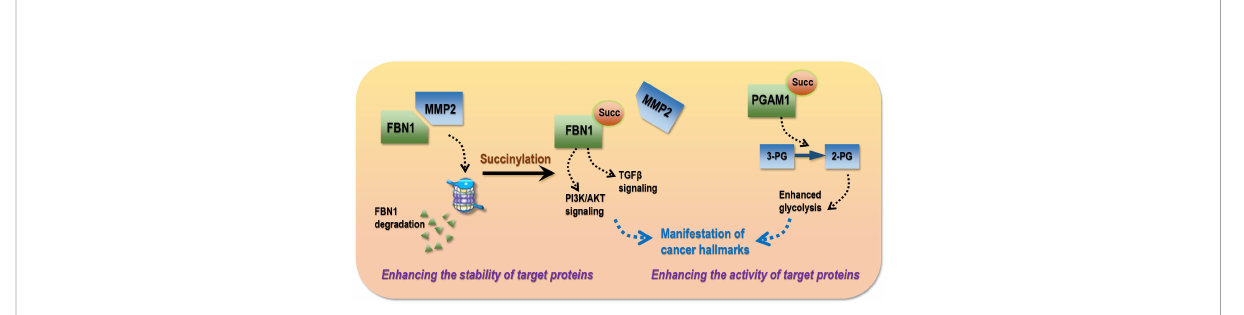
FIGURE 4 Modes of succinylation that drive the manifestation of cancer hallmarks in transformed cells. Succinylation drives cancer traits via two modes, i.e., enhancing the stability and/or activity of target proteins. As an example of the ‘ stability ’ mode, FBN1 over-expression promotes cancer progression by activating TGF- b 1 and PI3K/Akt signaling, succinylation of which is widely distributed in gastric tumors that blocks its interactions with MMP2 and thus MMP2-mediated protein degradation. As an example of the ‘ activity ’ mode, hyper-activated PGAM1 in hepatoma cells as a result of succinylation can enhance glycolysis and thus accelerate carcinogenesis. 3-PG, 3-phosphoglycerate; 2-PG,